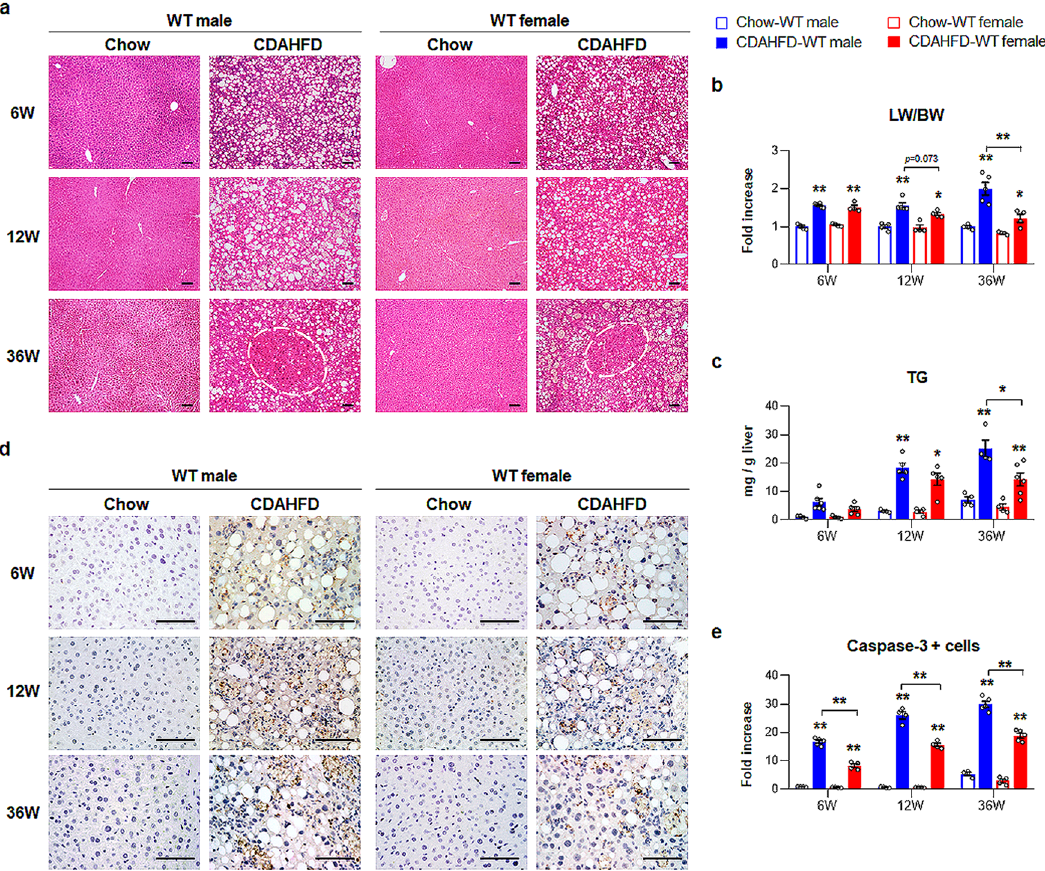
Fig. 1 Hepatic injury in CDAHFD fed male and female mice. a Representative images of the hematoxylin and eosin (H&E)-stained liver sections from wild- type (WT) male and female mice treated with chow or choline-de fi cient, L-amino acid-de fi ned, high-fat diet (CDAHFD). White circles indicate the area of nodules on the liver. b The ratio of liver weight to body weight (LW/BW) and c hepatic triglycerides (TG) amount from these mice. Data represent the mean ± S.E.M. ( n ≥ 4/group, * p < 0.05, ** p < 0.005 vs own control). d Representative images of active Caspase-3-immunohistochemical stained liver sections from these mice. All Scale bars show 50 μ m. e Quantitative active Caspase-3 immunohistochemistry data from these mice. The numbers of Caspase-3-positive cells were counted per fi eld and divided by the number of total hepatocytes per fi eld. Data represent the mean ± S.E.M. ( n ≥ 4/group, * p < 0.05, ** p < 0.005 vs own control). Gray circles represent individual data points. See Supplementary Data for statistical